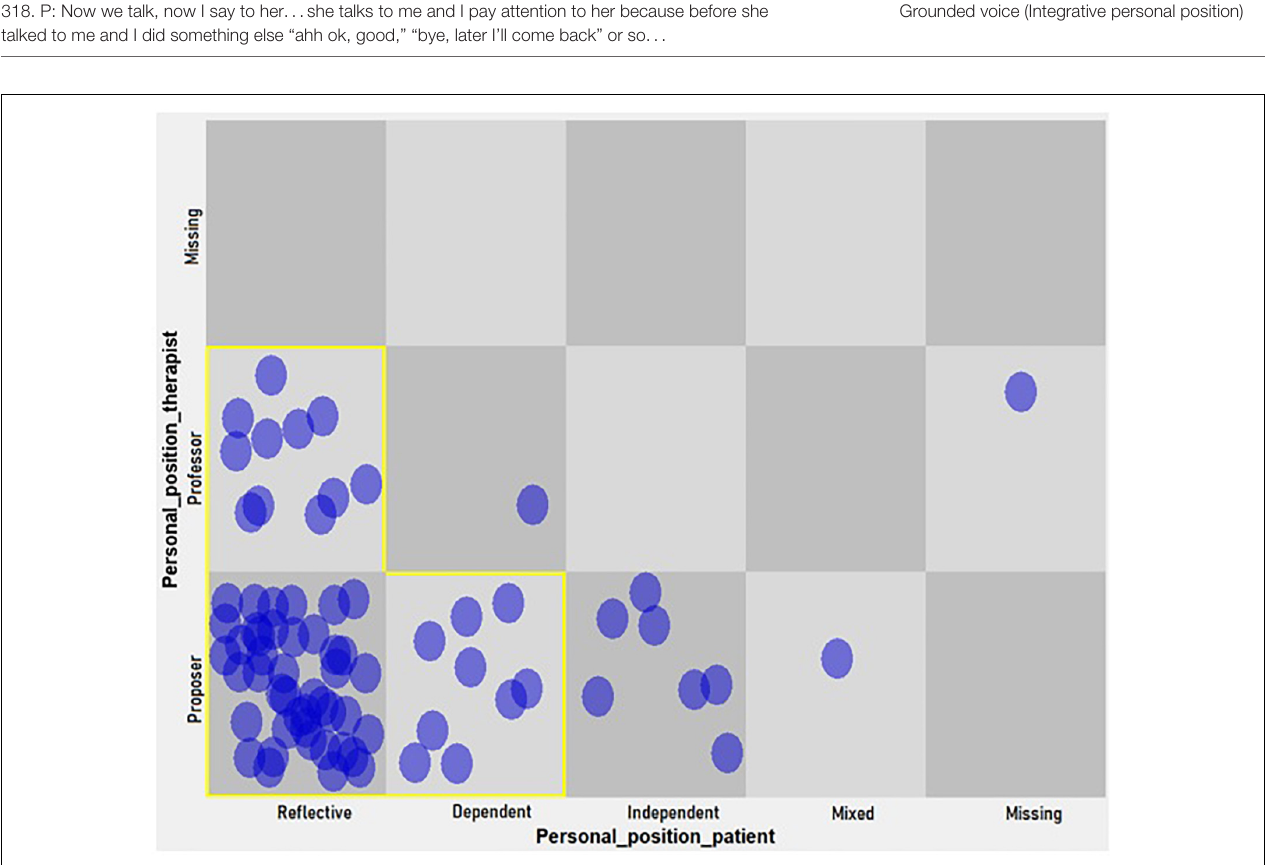
didn’t pay attention to her...